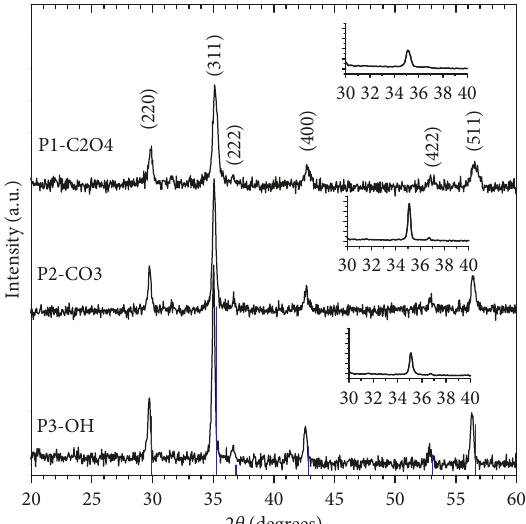
Figure 1: X-ray diffraction patterns of the ferrite powders obtained from different precursors by combustion method: P1-C2O4, P2-CO3, and P3-OH. Inset: diffractograms with high